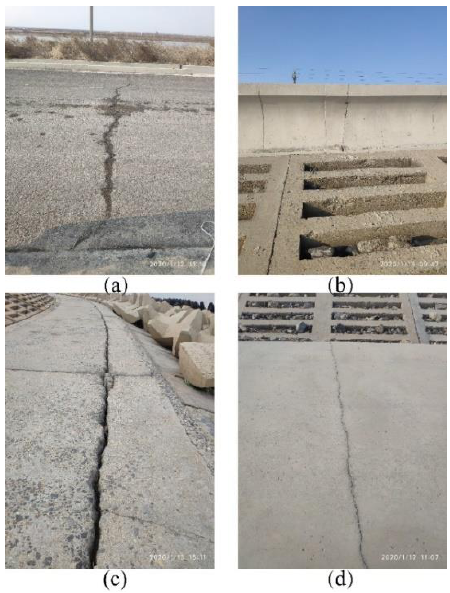
Figure 2. Pictures of cracks caused by dam deformation taken in January 2020: ( a ) cracks on asphalt pavement of the dam crest; ( b ) cracks on retaining wall; ( c ) longitudinal cracks on the first stage platform of the dam; ( d ) transverse cracks on the first stage platform of the dam.